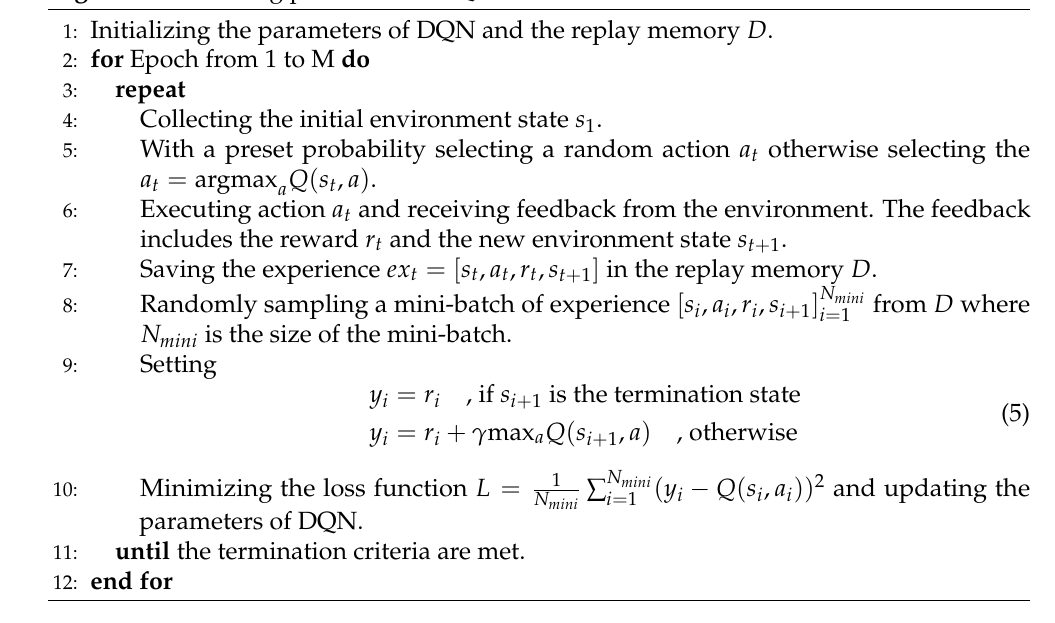
Algorithm 1 Training procedure of